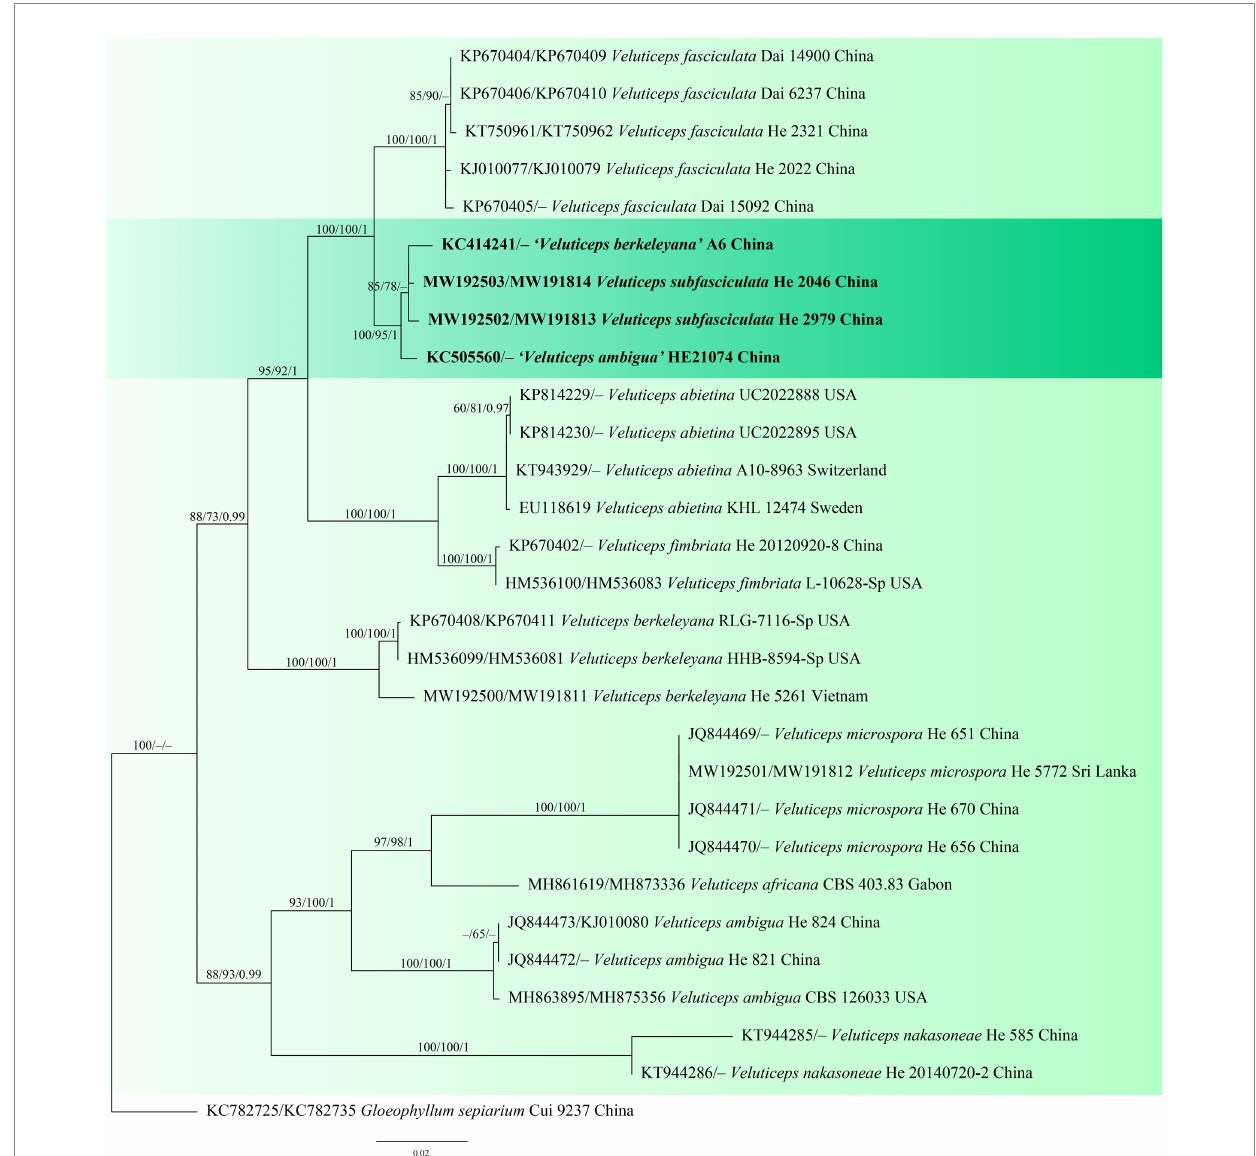
FIGURE 2 Phylogenetic tree obtained from ML analysis of the ITS-28S sequences of Veluticeps . Branches are labelled with parsimony bootstrap values ( ≥ 50%, first), likelihood bootstrap values ( ≥ 50%, second) and Bayesian posterior probabilities ( ≥ 0.95, third). New species are set in bold and